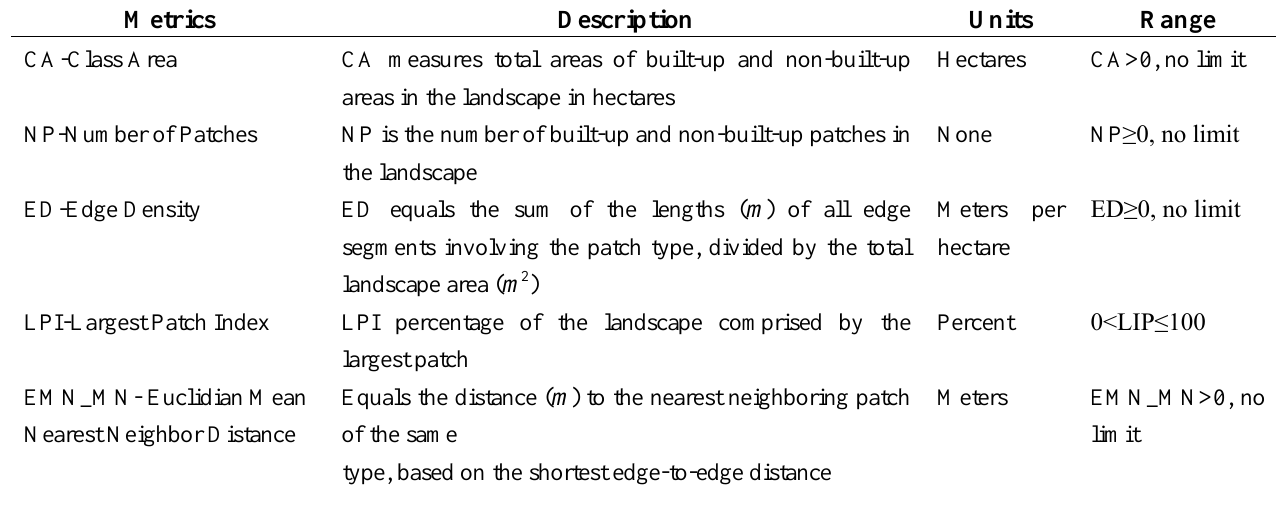
Table 2. Spatial metrics used in the